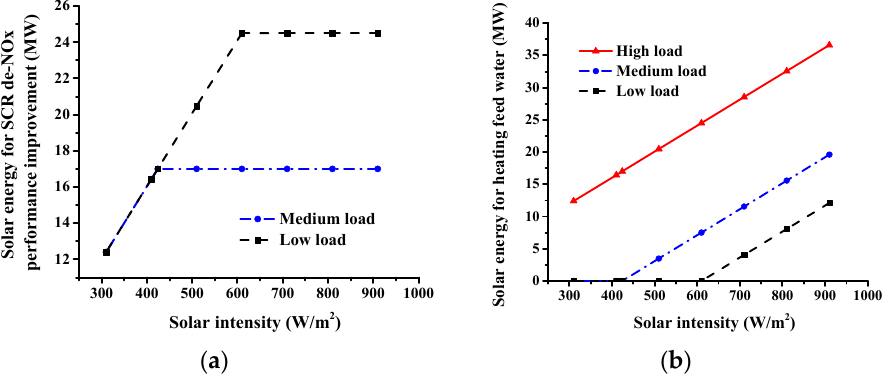
Figure 10. Influence of solar intensity on solar energy contribution. ( a ) For SCR de-NO x performance improvement; ( b ) for heating feed water.